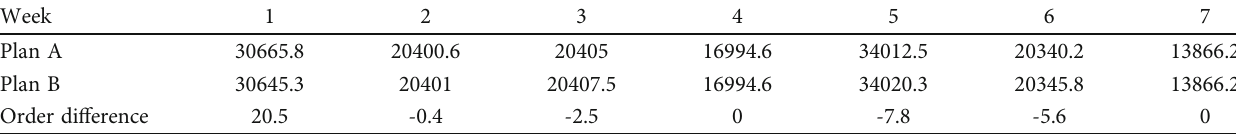
Table 3: The di ff erent order quantity after changing the optimization objective (unit: m 3 ).